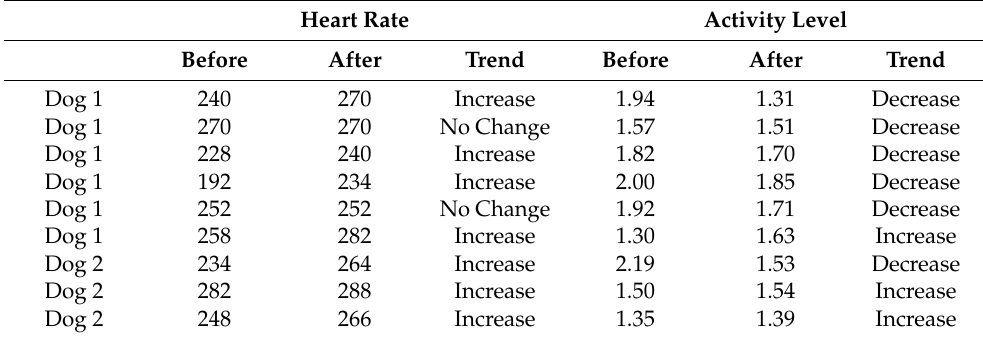
Figure 6. Heart rate estimation (blue) overlaid with the IMA (orange). The three bumper retrieval events are enumerated in red. Table 1. Heart rate and activity level trends ten seconds before and after bumper